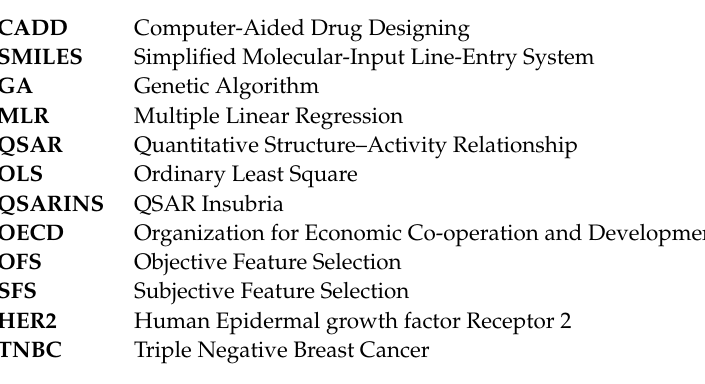
Figure S2: Different graphs associated with model 1.2 (a) graph of pred. endpoint vs. residual values (b) Y-scrambling plot. Statistical parameters for used for validation of QSAR